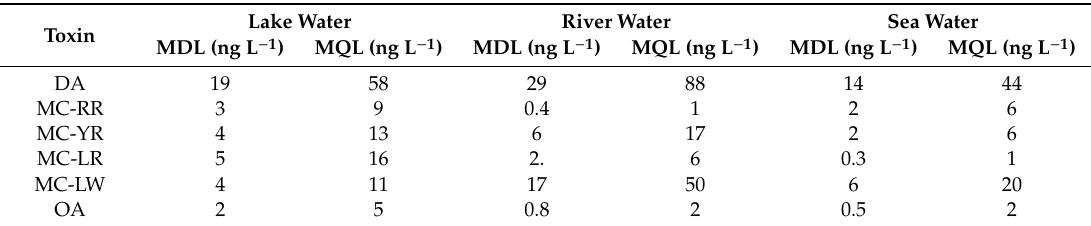
Table3. MethodDetectionLimits(MDLs)andMethodQuantificationLimits(MQLs)foreachcompound in di ff erent matrices.